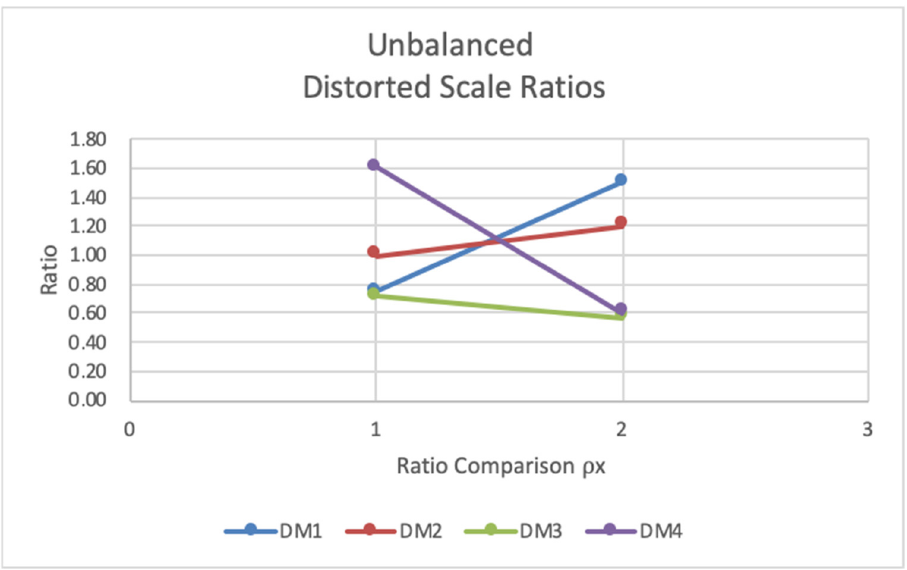
Figure 12. Case #18 unbalanced distorted scale ratios (extreme bias).